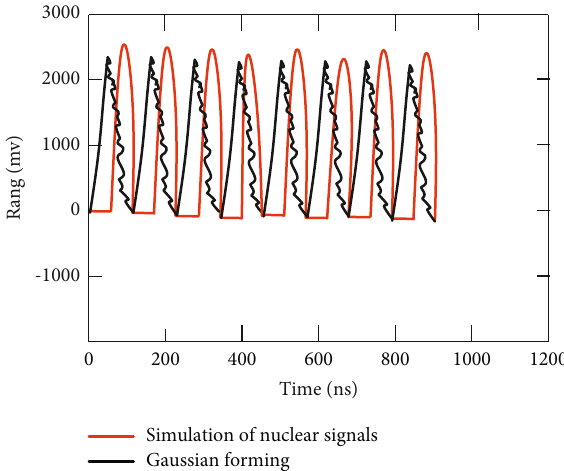
Figure 4: Amplitude spectrum distribution of analog and digital engineering cost data signal (1024